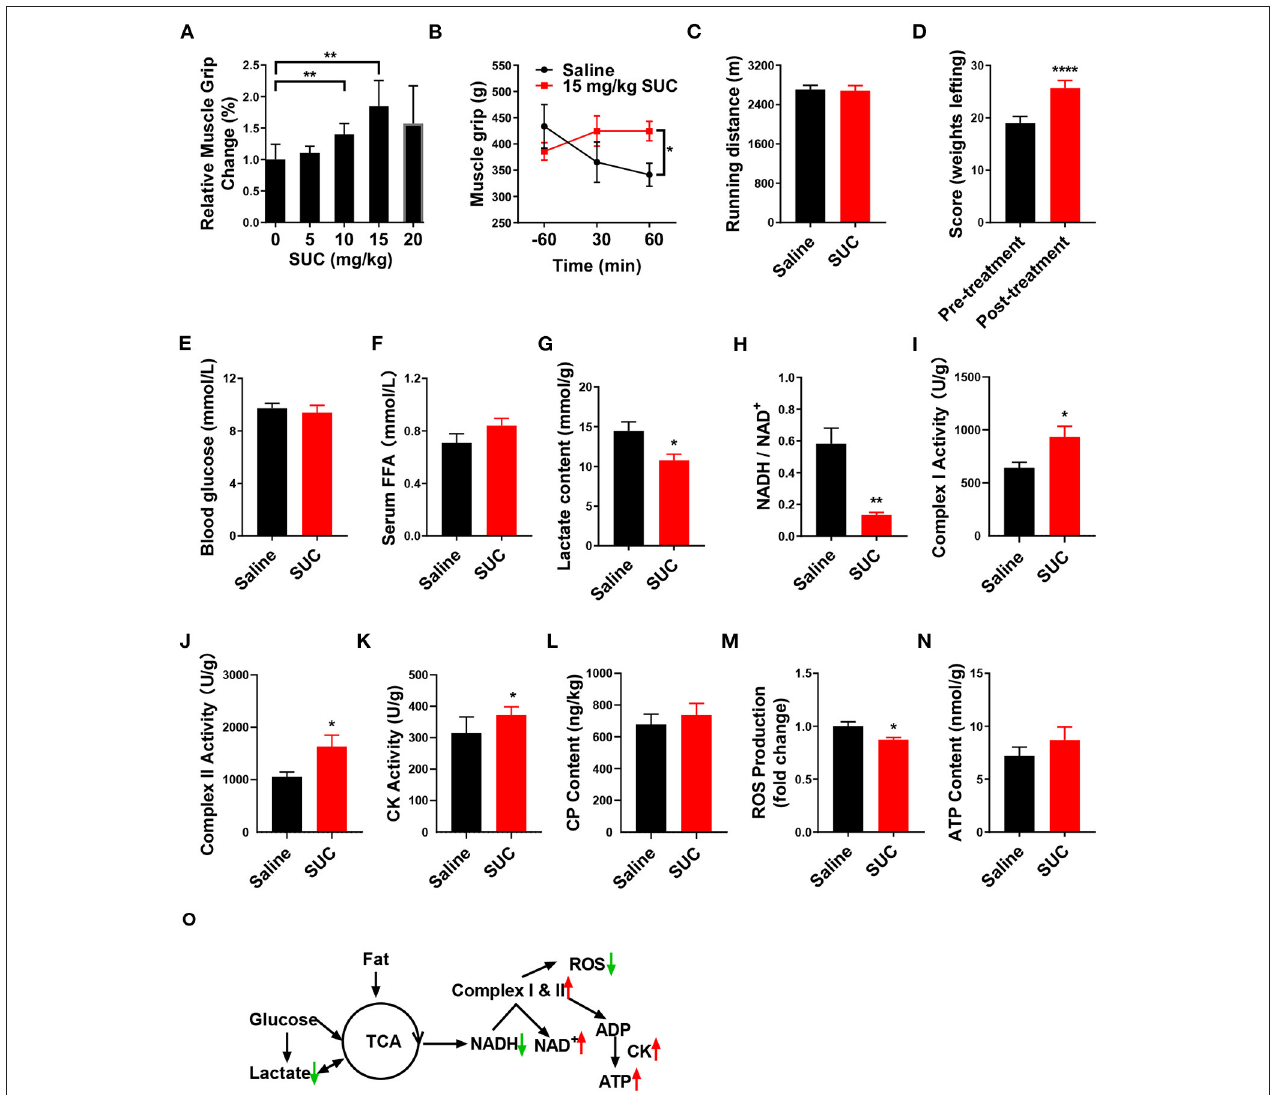
FIGURE 1 | SUC increases explosive strength and mitochondrial oxidative phosphorylation in mice. (A) Relative muscle grip of the mice injected with different doses of SUC or saline for 1h. (B) Muscle grip change at different times after injection of 15 mg/kg SUC. (C) Running distance of the mice after injecting with saline and SUC for 1h. (D) Weight lifting of the mice after being injected with saline and SUC for 1h again. Blood and gastrocnemius were collected after the muscle grip test for (E–N) results to detect. (E) Blood glucose content. (F) FFA level in serum. (G) Lactate content in muscle. (H) NADH/NAD + ratio change in muscle. (I) Complex I activity in muscle. (J) Complex II activity in muscle. (K) Muscle CK activity in muscle. (L) Muscle phosphocreatine (CP) content. (M) Muscle ROS content. (N) Muscle ATP content. (O) Schematic diagram of energy production pathway in normal conditions. In the normal process of energy production, acetyl-CoA from glycolysis of glucose and subsequent oxidation of pyruvate and β -oxidation of fatty acid produces NADH by TCA cycle (3). The electrons from NADH pass through the mitochondrial electron transport chain and synthesize ATP by CK in the mitochondrial outer compartment (23). Premature leakage of electrons in the